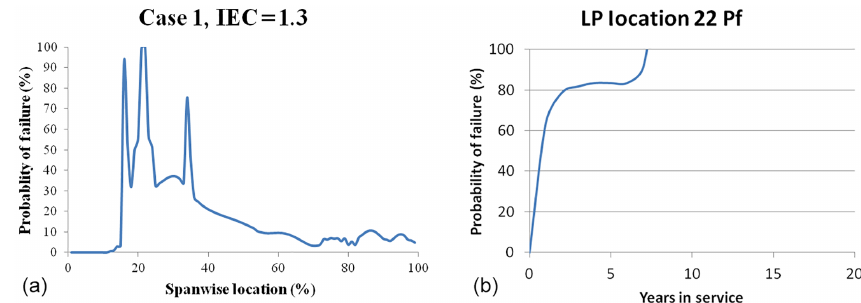
Figure 15. Probability of failure by location (a) and as a function of time for location 22 (b) .